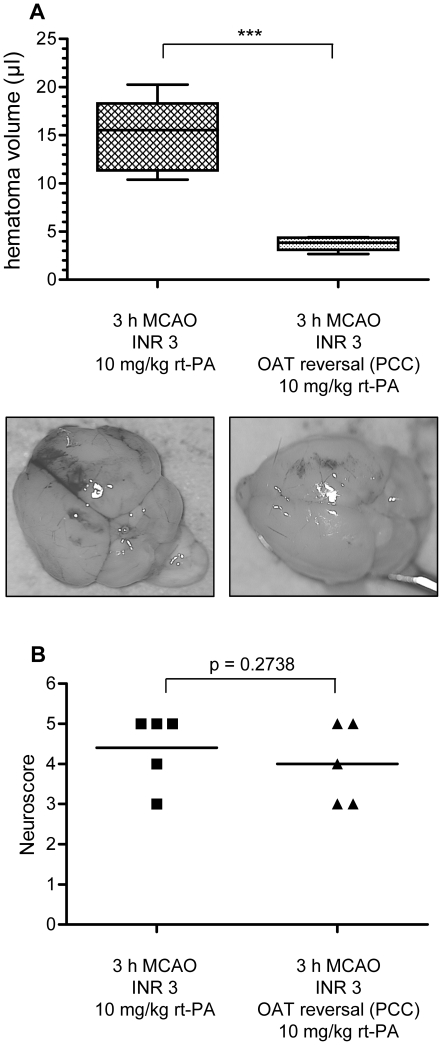
Reversal of anticoagulation with PCC diminishes the excessive rt-PA-associated risk of hemorrhagic transformation in warfarin-treated mice.A) Anticoagulated mice treated with i.v. rt-PA (10 mg/kg) after 3 h MCAO develop large intracerebral hematomas (left, n = 5). Reversal of oral anticoagulation with i.v. PCC (100 IU/kg) directly before the administration of rt-PA counterbalances the excessive risk of hemorrhagic transformation (right, n = 5). Statistical significance was essayed with student's unpaired, two-tailed t-test. ** p<0.001. B) Neuroscores were analyzed for statistical significance with a one-tailed Mann Whitney test and the p-value given as a Gaussian approximation (median values 5 and 4, p = 0.2738).